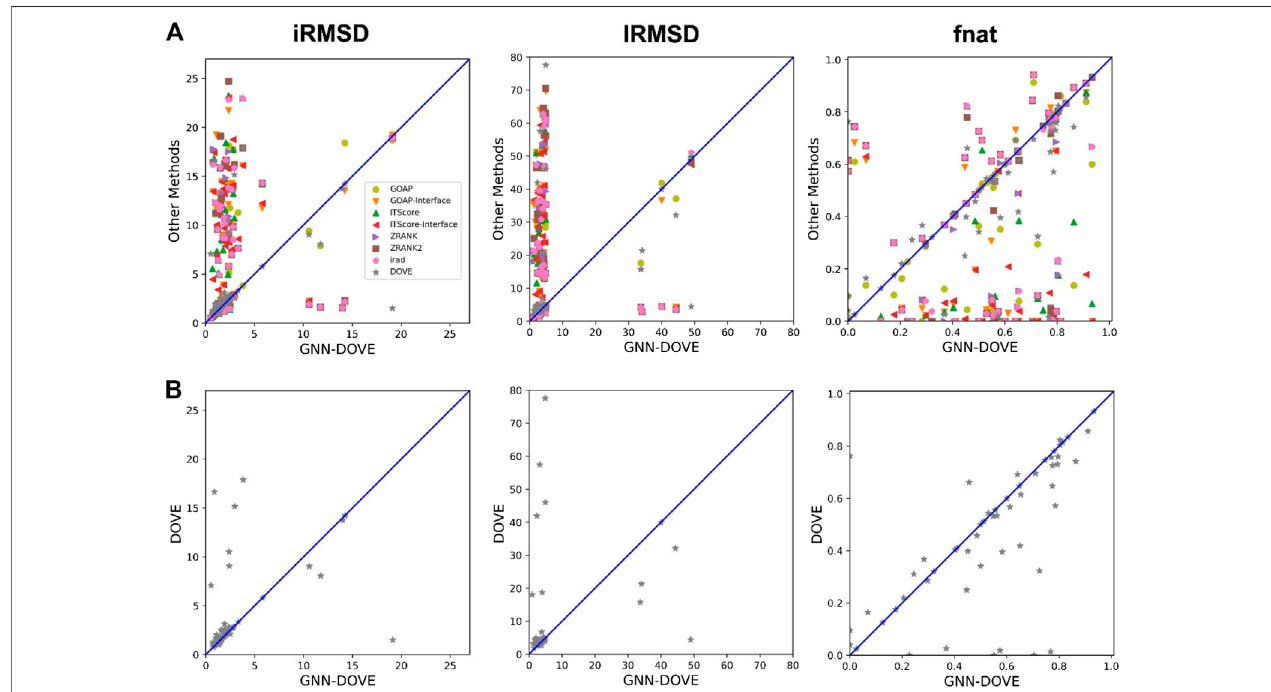
FIGURE 4 | Comparison of iRMSD, lRMSD, and fnat. For each method, the best value among the top 10 scored decoys was plotted. (A) Comparison against all eight methods. (B) Comparison against